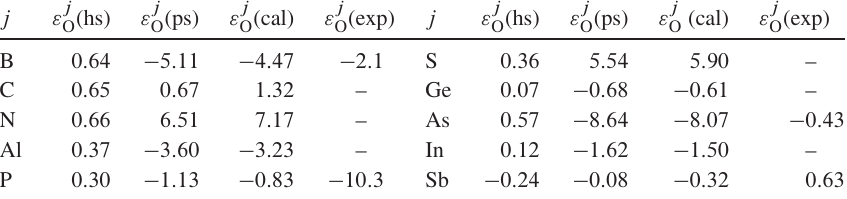
Table 4. Interaction parameters for oxygen in silicon melt with available experimental data at 1773K. One additional example is described below. Silicon